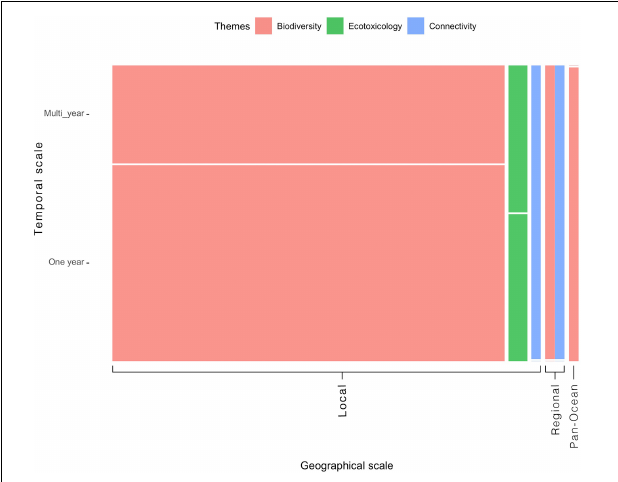
FIGURE 2 | The proportion of published peer-reviewed literature on oil and gas decommissioning ( n = 48) that were classified into different themes, and into spatial and temporal categories. Note categories with zero counts (i.e., “restoration” and “other” in the Themes variable are not